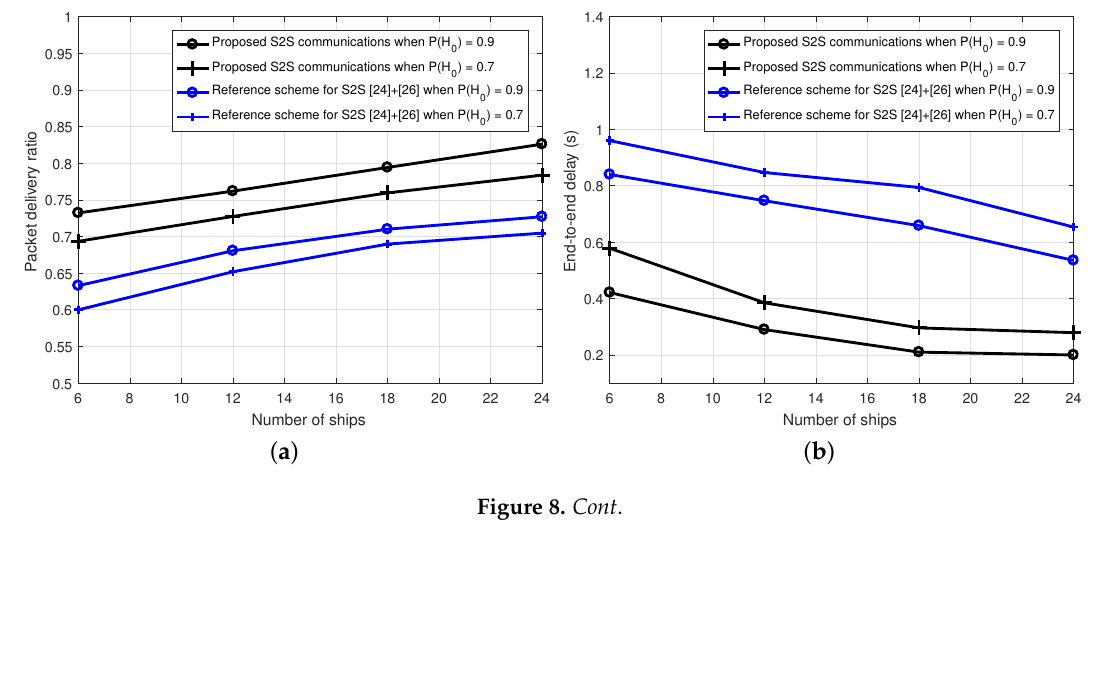
Figure 7. Performance comparison between the proposed V2V and the reference scheme for V2V in terms of ( a ) packet delivery ratio, ( b ) end-to-end delay, and ( c ) routing overhead ratio.